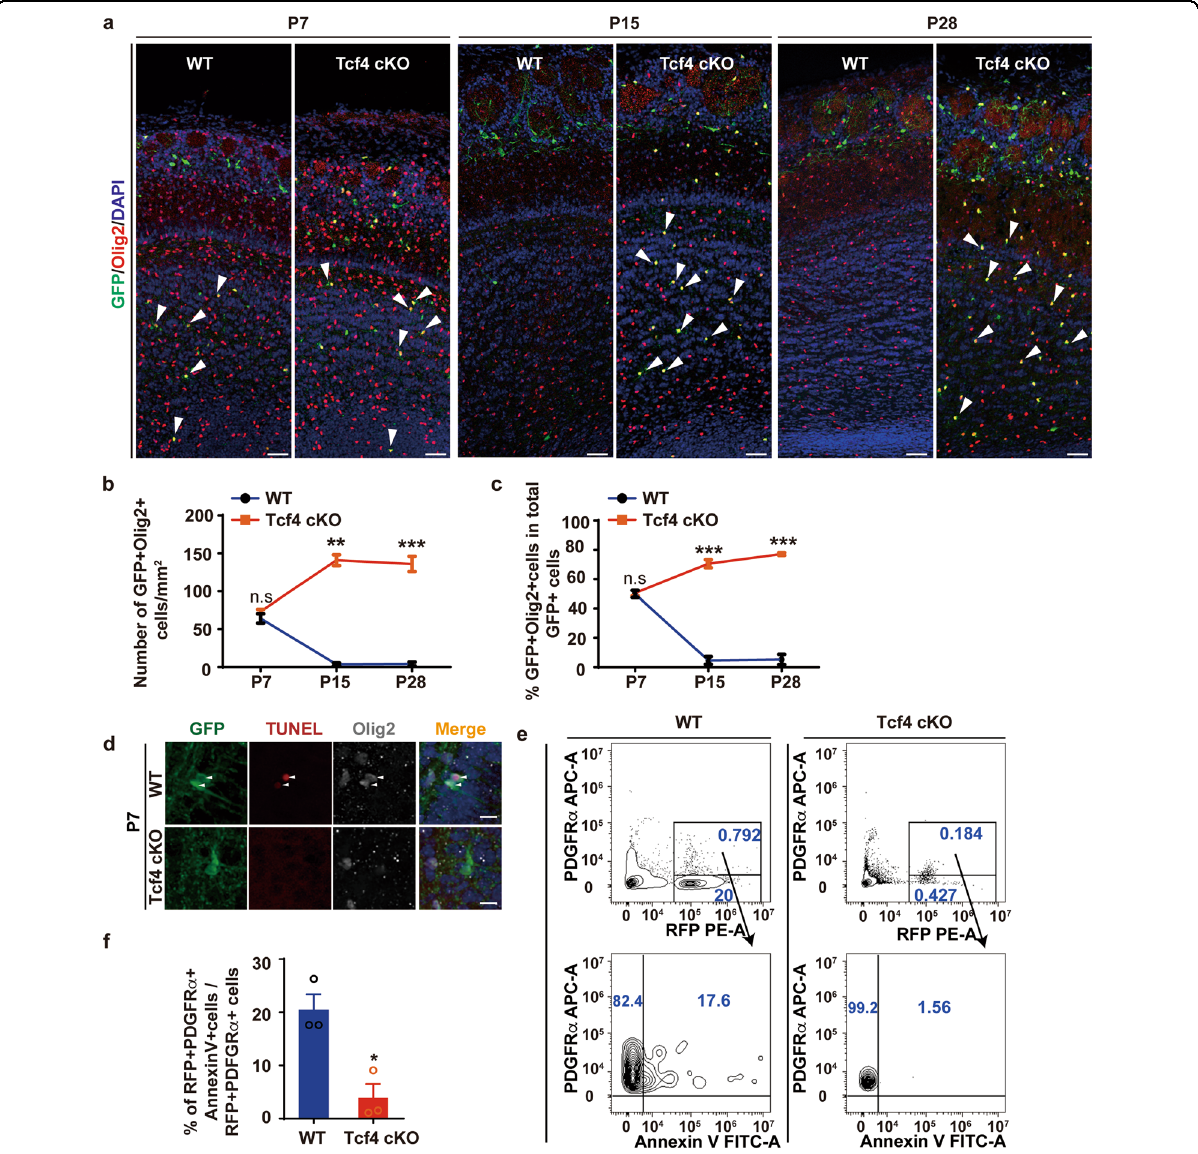
Fig. 4 Loss of Tcf4 results in programmed cell death in OPCs. a Representative images of immunostaining for GFP and Olig2 at various developmental stages in both WT and Tcf4 cKO OBs. Arrowheads show OPCs. Scale bar: 50 μ m. b , c Quanti fi cation of the density of OPCs ( b ) and the proportion of Nkx2.1-derived OPCs ( c ). Student ’ s t test was used to compare two groups. Data are presented as mean ± SEM. * p < 0.05, ** p < 0.01, and *** p < 0.001. At least three OBs were analyzed for each genotype. d Representative images of immunostaining of GFP, TUNEL, and Olig2 in WT and Tcf4 cKO OBs at P7. Arrowheads indicate the OPCs undergoing cell death. Scale bar: 25 μ m. e FACS analysis of OPCs undergoing cell death. f Quanti fi cation of the proportion of AnnexinV-positive OPCs in both WT and Tcf4 cKO OBs. Student ’ s t test was used to compare two groups. Data are presented as mean ± SEM. * p < 0.05, ** p < 0.01, and *** p < 0.001. At least three OBs were analyzed for each